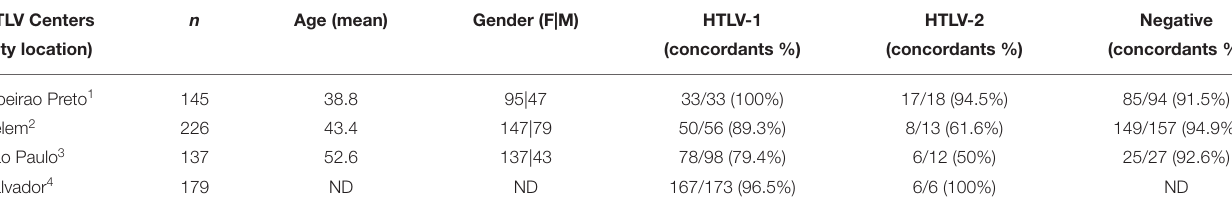
TABLE 3 | Multicentric evaluation of the duoplex-RT-PCR-HTLV1/2 platform. HTLV